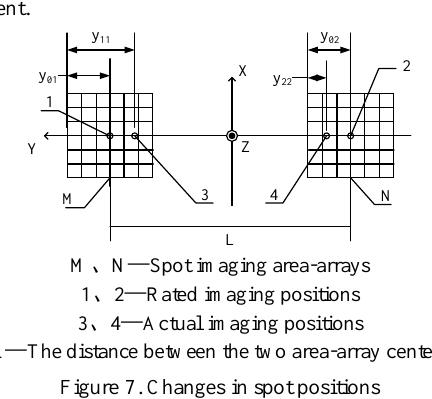
Figure 7. Changes in spot positions